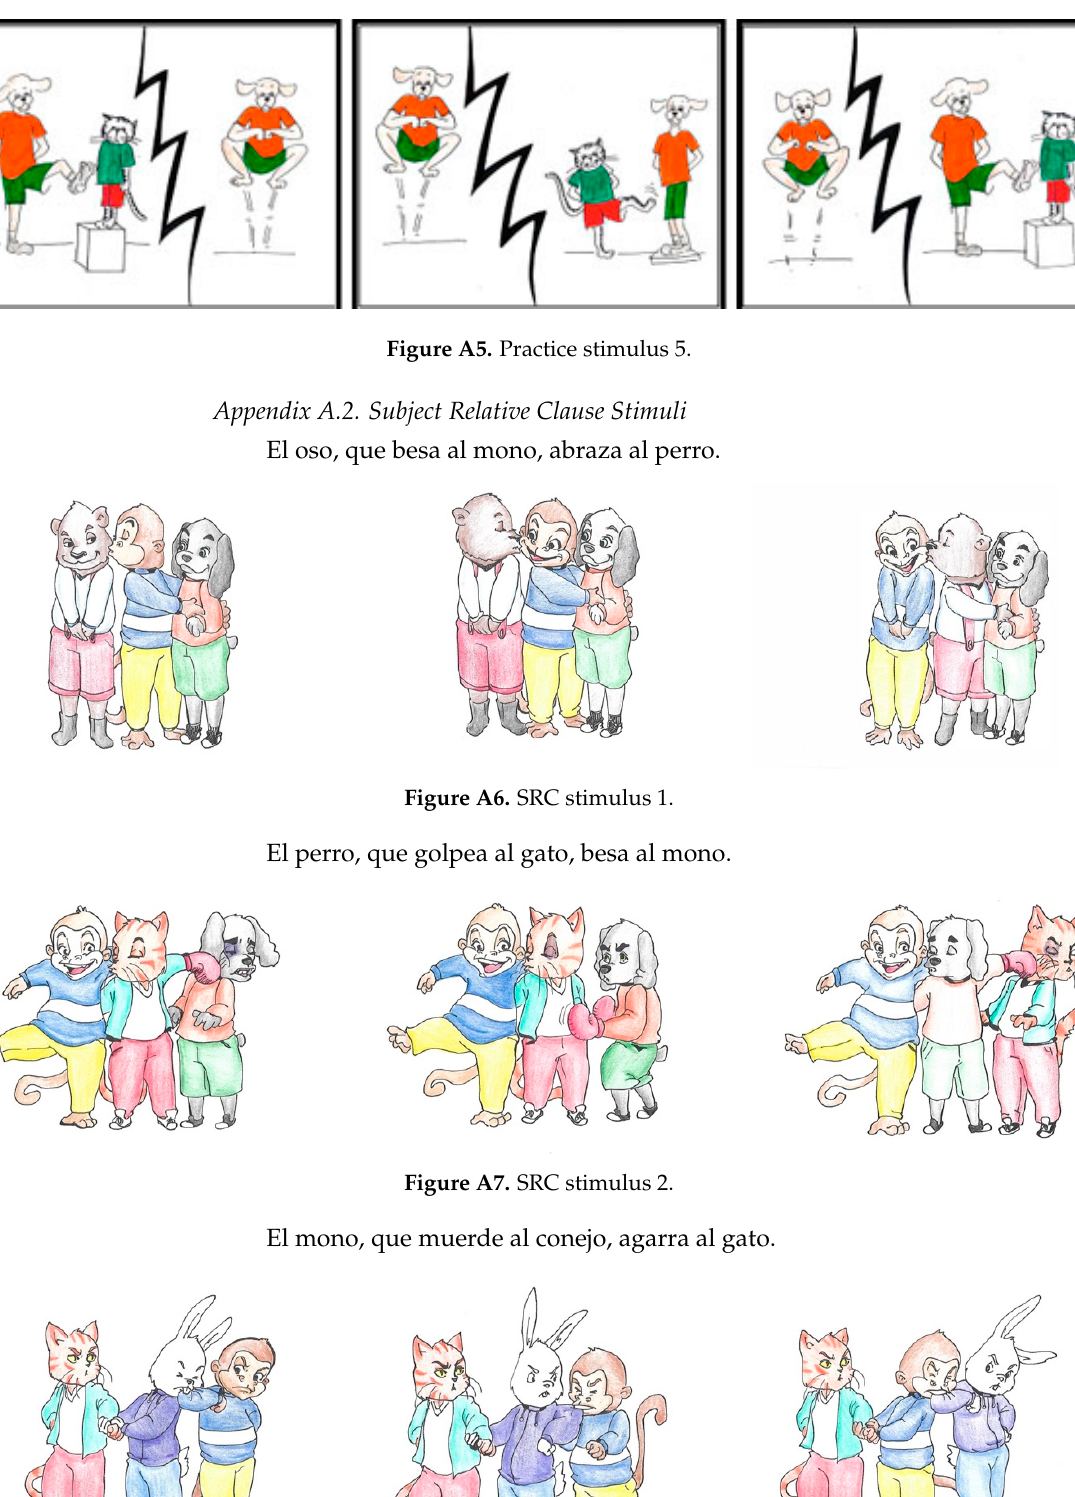
Figure A4. Practice stimulus 4.